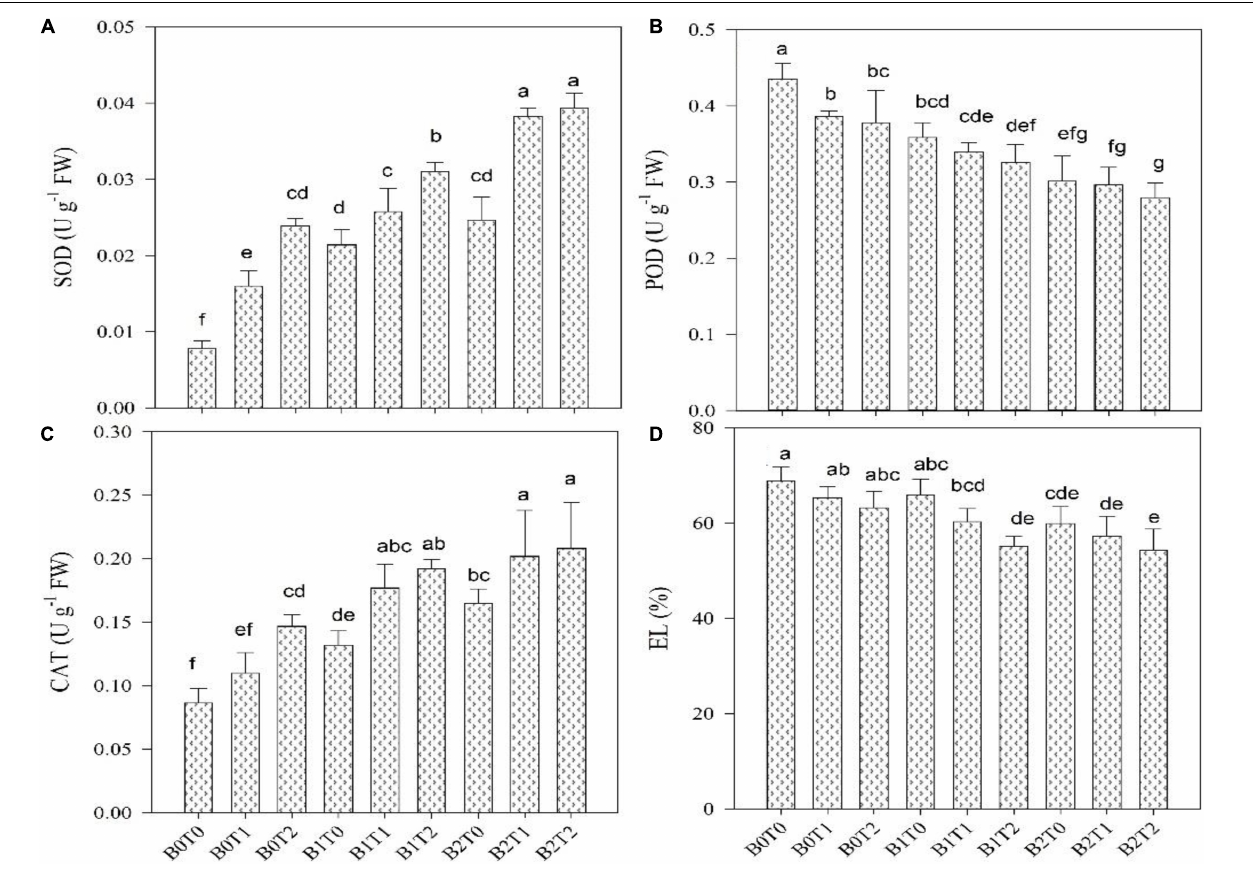
Figure 3 | Effect of combined application of TU and BC on (A) superoxide dismutase (SOD), (B) peroxidase (POD), (C) catalase (CAT), and (D) electrolyte leakage (EL), grown under Cd contamination. Values are averages ± SD ( n = 3). Different statistical letters represent significant differences in values between treatments ( p < 0.05). TU, thiourea; BC, biochar; T 0 = 0 mg L − 1 ; T 1 = 600 mg L − 1 ; T 2 = 600 mg L − 1 ; B 0 = 0% w/w; B 1 = 2.5% w/w; B 2 = 5.0% w/w.